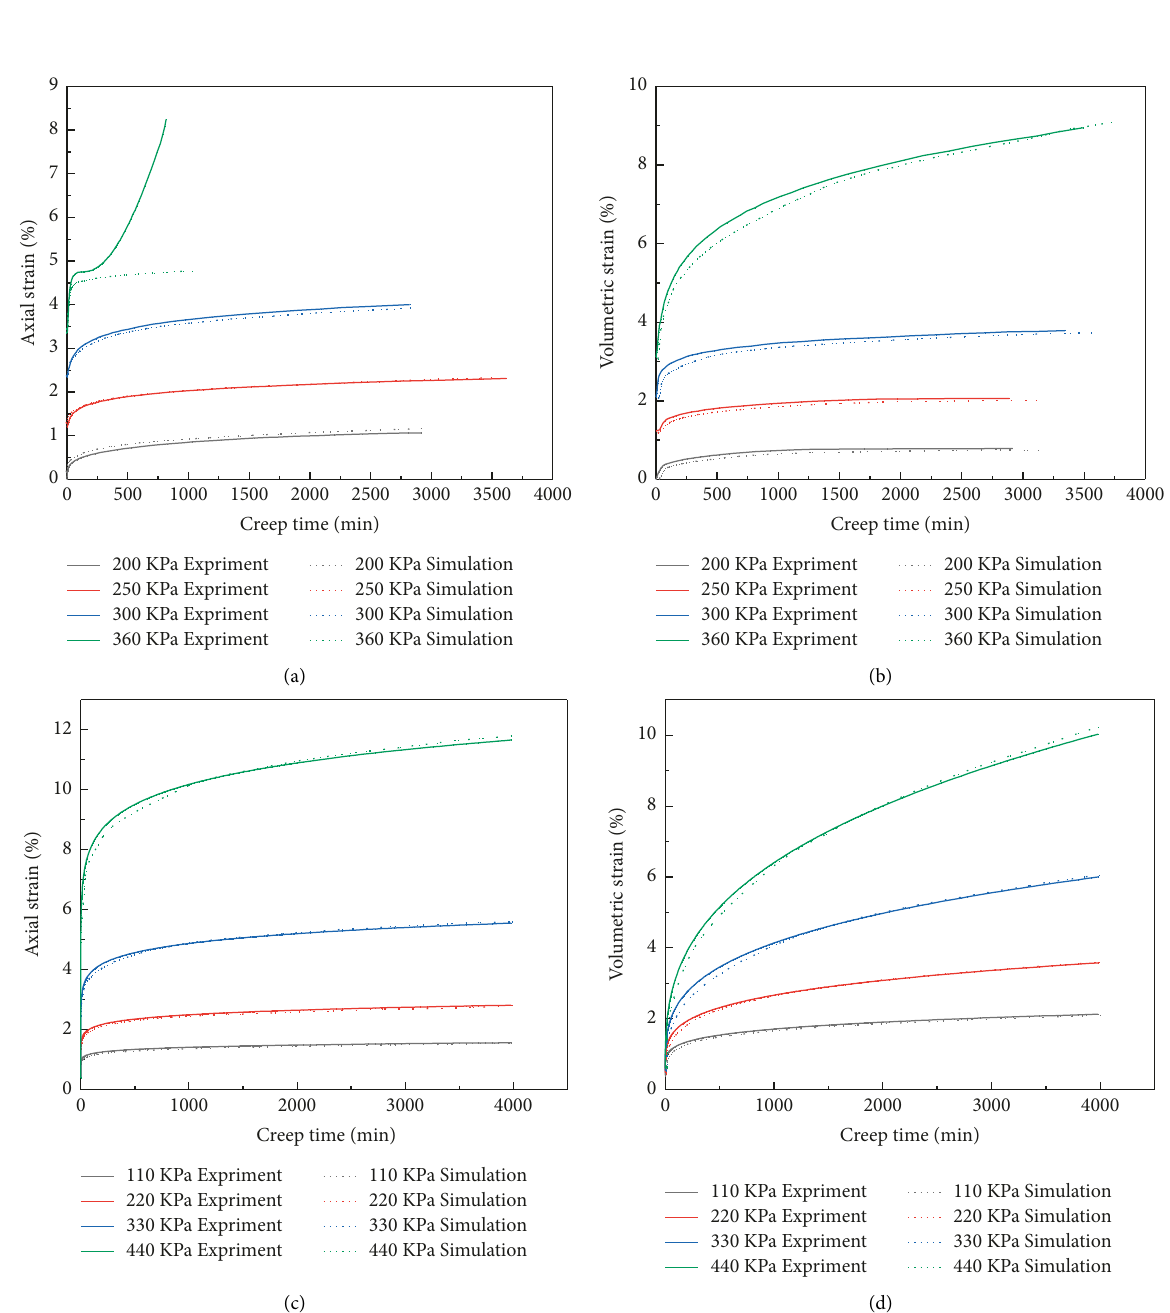
Figure 13: Comparison of the calculated values and the measured values of drained triaxial creep tests on silted soil in front of dam: (a) axial ′ � 200kPa); (b) volumetric creep strain vs. creep time ( σ strain vs. creep time ( σ 3 ′ � 300kPa). (d) volumetric creep strain vs. creep time ( σ 3